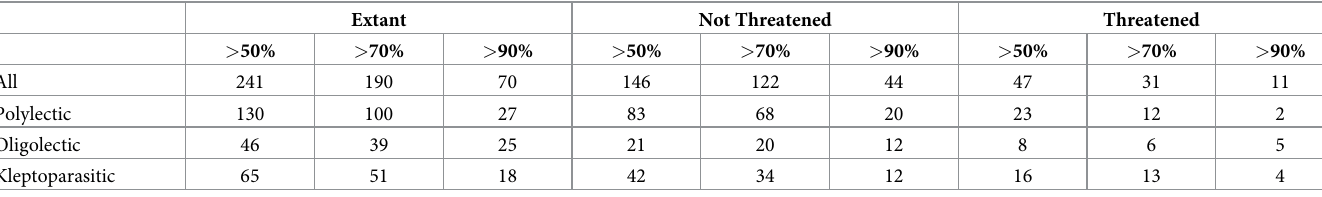
Categories are for all bees, but also divided for polylectic, oligolectic and kleptoparasitic species. The latter does not collect pollen, but usurp the nest and consume the pollen of its host. All 19 regionally extinct species and the honey bee have been excluded from the present